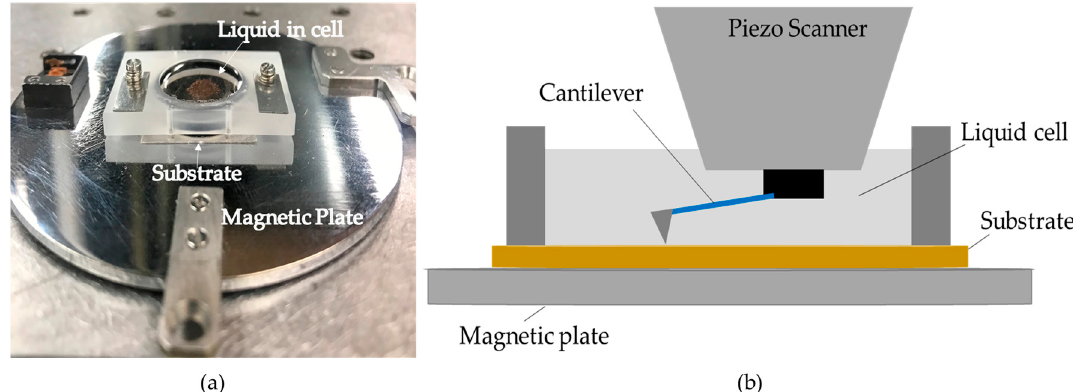
Figure 4. AFM liquid cell design: ( a ) an image of the cell containing a test solution (brine or nanofluids) pinned with the substrate to a magnetic plate; and ( b ) a graphic of the overall setup as the tip scans the substrate area after equilibration. This is an open cell design: the liquid level is open to air so the liquid can evaporate over time.